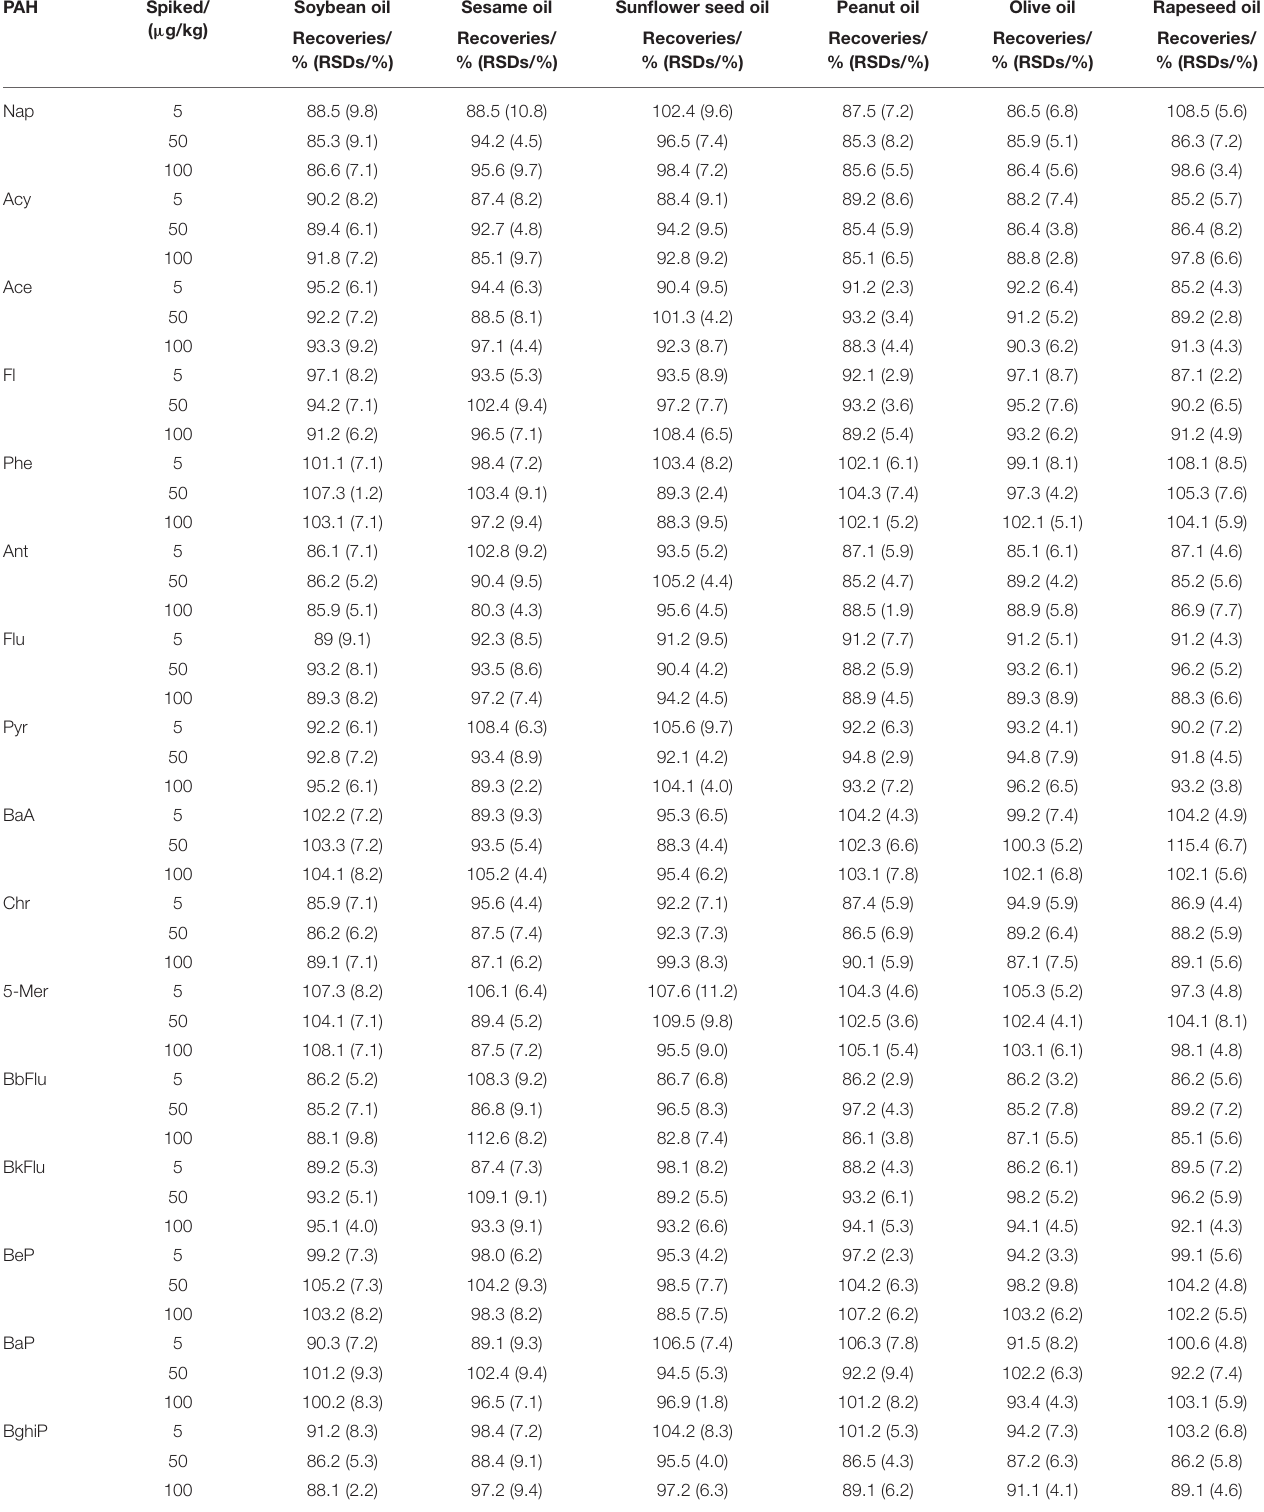
TABLE 4 | Recoveries and RSDs of soybean oil, sesame oil, sunflower seed oil, peanut oil, olive oil, and rapeseed oil samples at three spiked levels of the 22 PAHs. PAH Spiked/ Soybean oil Sesame oil Sunflower seed oil Peanut oil Olive oil Rapeseed ( µ g/kg)